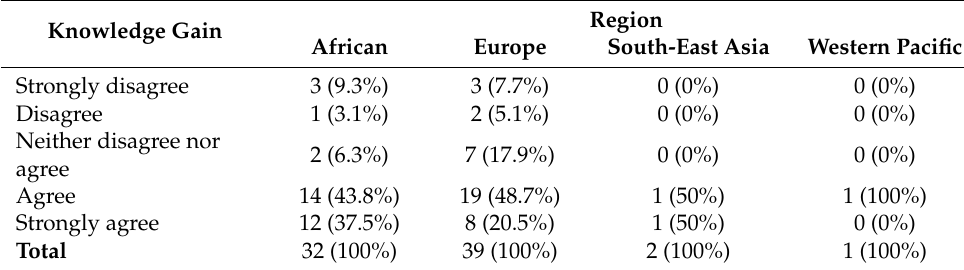
Table 5. Knowledge gain according to geographic